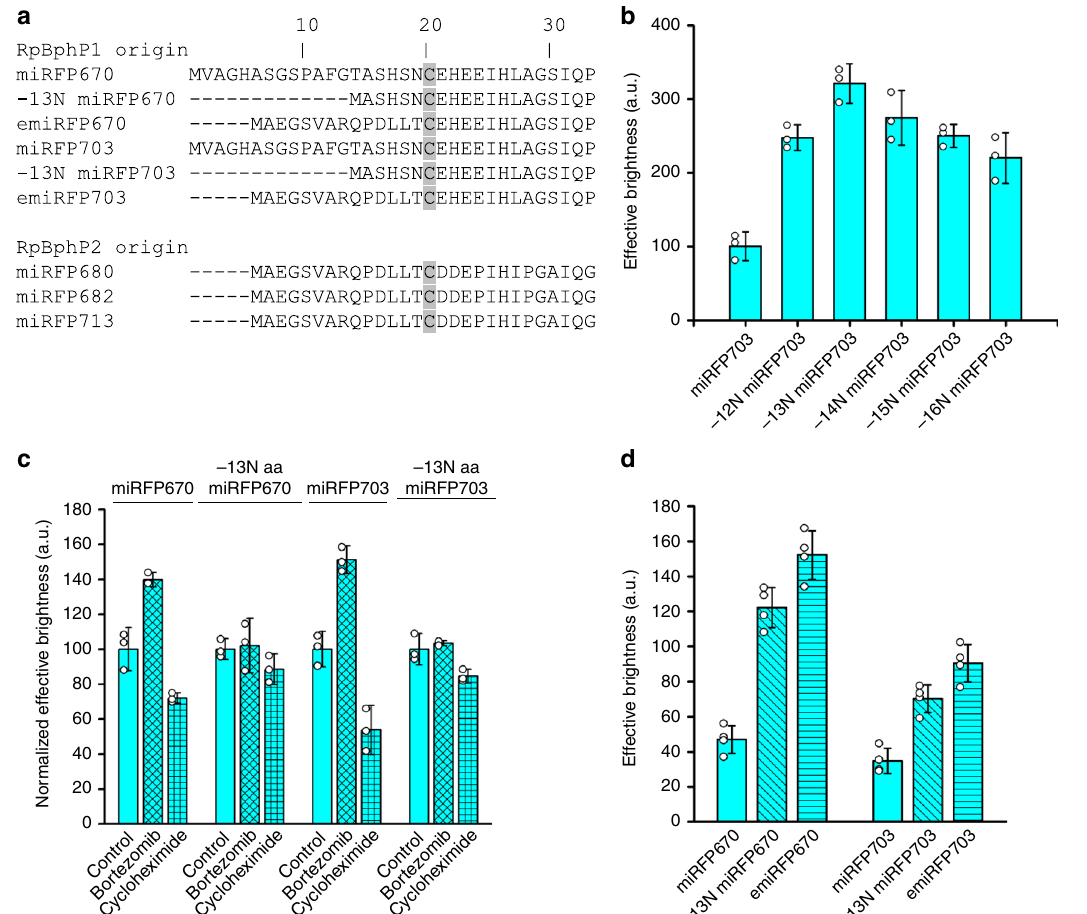
Fig. 2 Engineering of enhanced miRFPs. a Alignment of N-termini of monomeric NIR FPs derived from RpBphP1 and RpBphP2. b Effective brightness of miRFP703 variants with 12 – 16 amino acid residues removed from the N-terminus. Analysis was performed in COS-1 cells using fl ow cytometry 72 h after transfection. The effective brightness of the original miRFP670 was assumed to be 100% for normalization. c Effective brightness of miRFP670 and miRFP703 and their variants with 13 amino acid residues removed from N-terminus in control cells and after 4 h incubation with 10 µ M proteasome inhibitor bortezomib or 50 µ g ml − 1 ribosome blocker cycloheximide in live COS-1 cells. Error bars, double s.e.m. ( n ≥ 3; transfection experiments). Brightness of FPs in control cells was assumed to be 100% for normalization. d Effective brightness of miRFP670 and miRFP703, their variants with 13 amino acid residues removed from N-terminus, and their variants with N-termini of RpBphP2. Measurements were performed in COS-1 cells 72 h after transfection. Effective brightness of miRFP720 was assumed to be 100% for